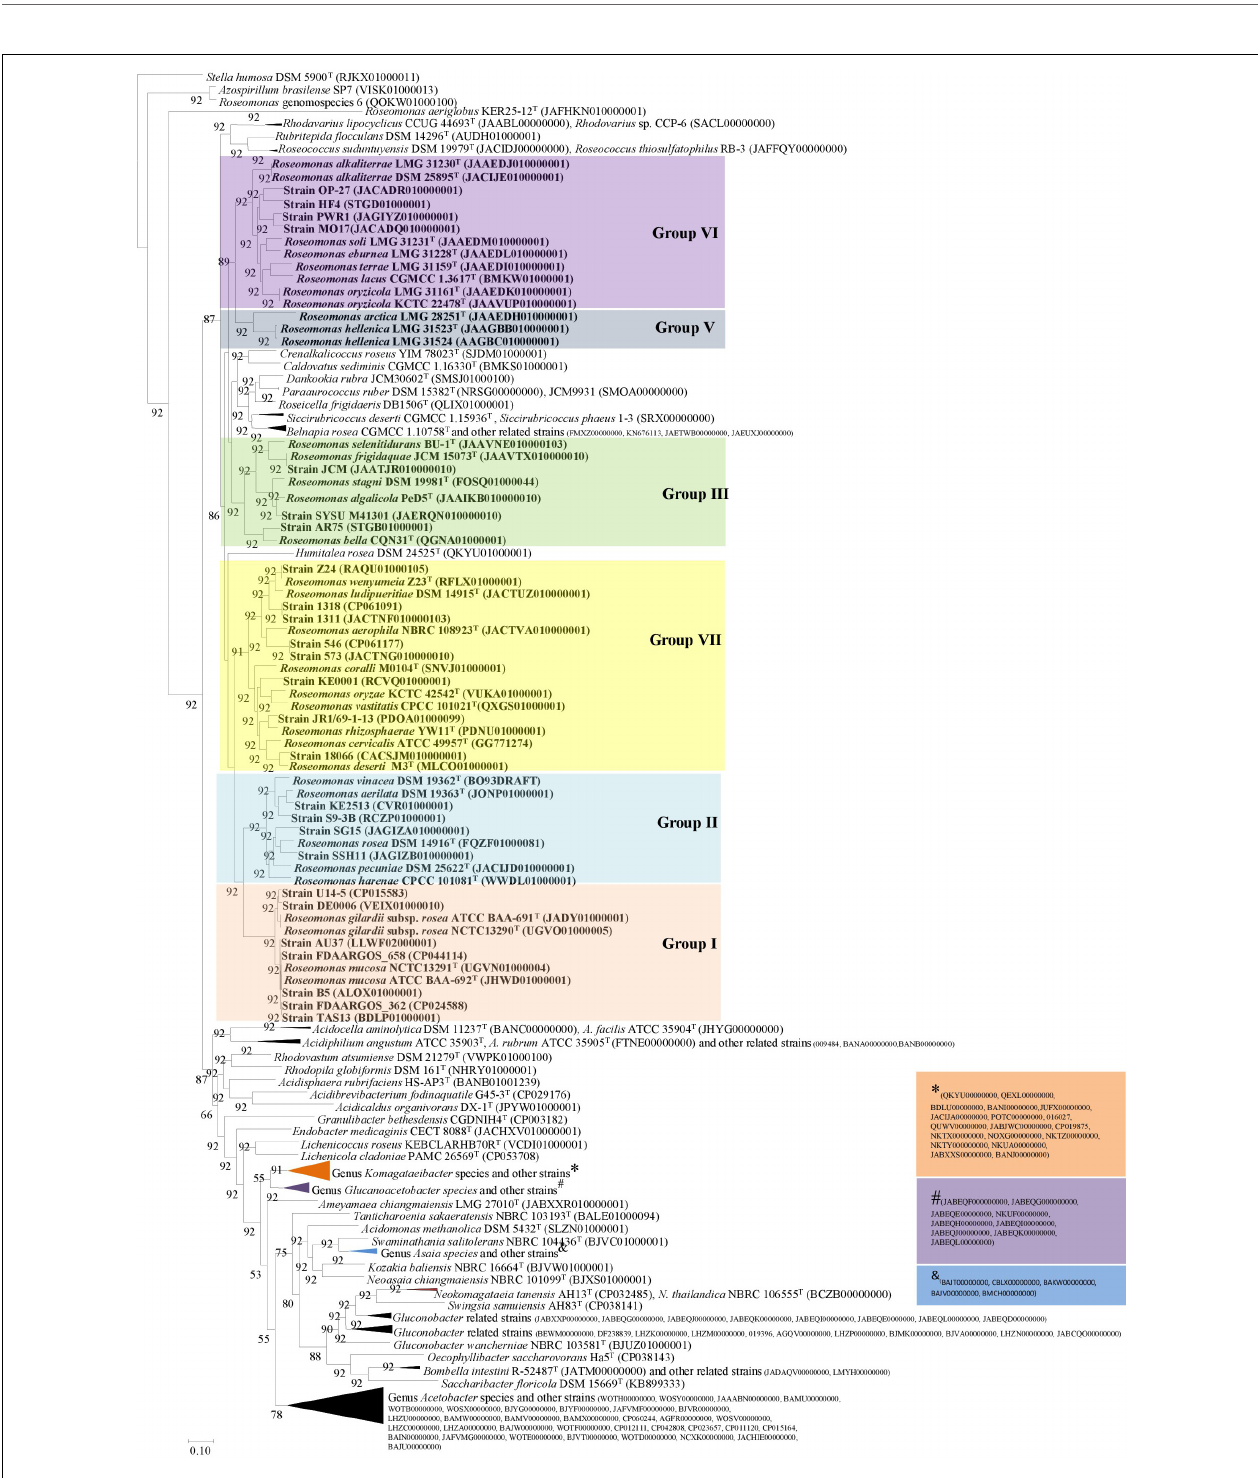
FIGURE 2 | Phylogenomic tree constructed using 92 core genes tool based on the Up-to-date Bacterial Core Gene (UBCG) (Na et al., 2018). The tree was generated using the MEGA7 software (NJ) with Stella humosa DSM 5900 T (RJKX00000000) as an outgroup.